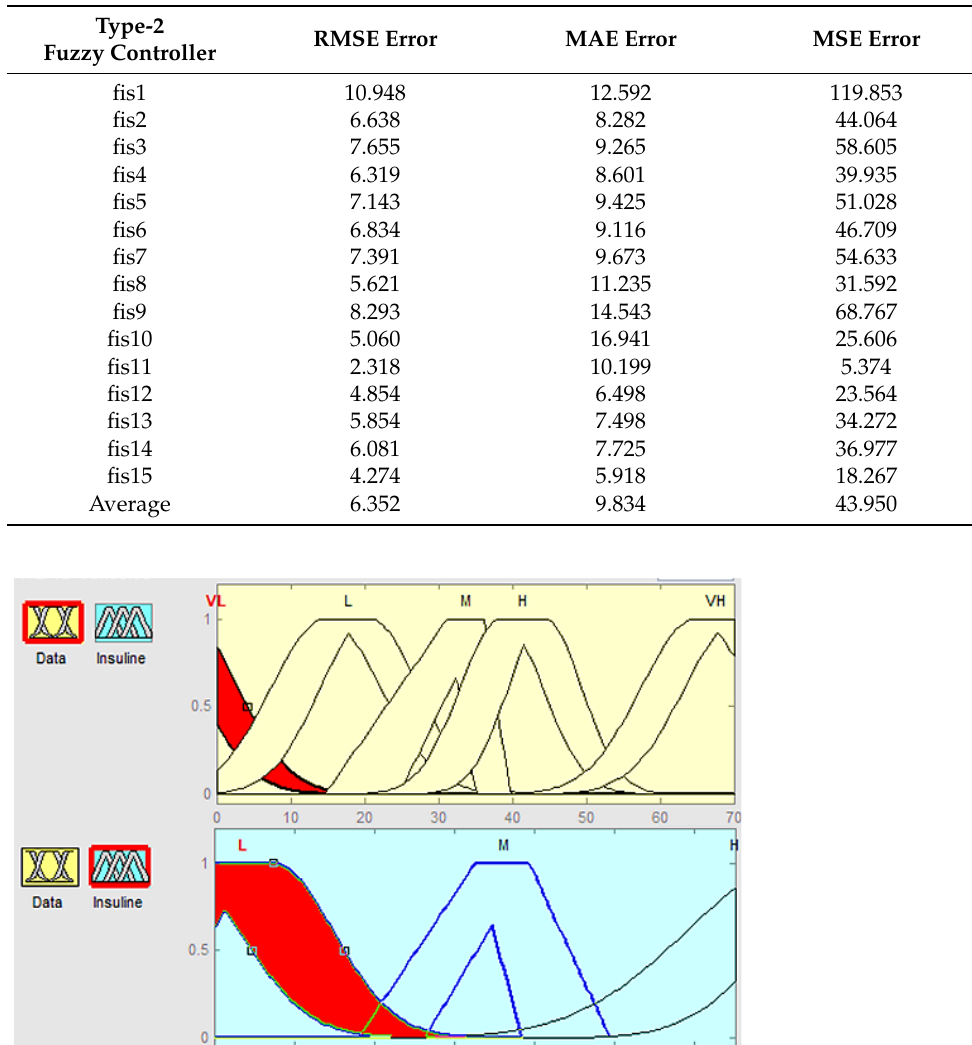
Table 4. Results for the type-2 fuzzy control for optimal supply of insulin.